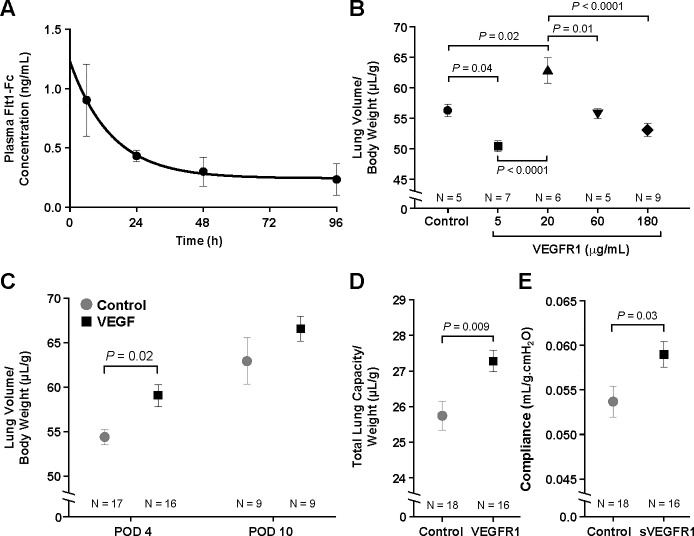
VEGFR1 paradoxically enhanced compensatory lung growth (CLG).Plasma concentration of VEGFR1-Fc was measured at various time points after injection and its half-life was measured to be 10.3 hours (A). In the dose-response study, VEGFR1 at 5 μg/kg decreased lung volume measured on post-operative day (POD) 4 after left pneumonectomy (PNX) compared to the control group (B). However, the dose of 20 μg/kg resulted in a paradoxical increase in lung growth. This result was confirmed across 3 different repetitions, where VEGFR1 at 20 μg/kg significantly improved CLG on POD 4 (C). VEGFR1 treatment also resulted in improved total lung capacity (D) and pulmonary compliance (E) on POD 4. Data are expressed as mean ± standard error (SE).